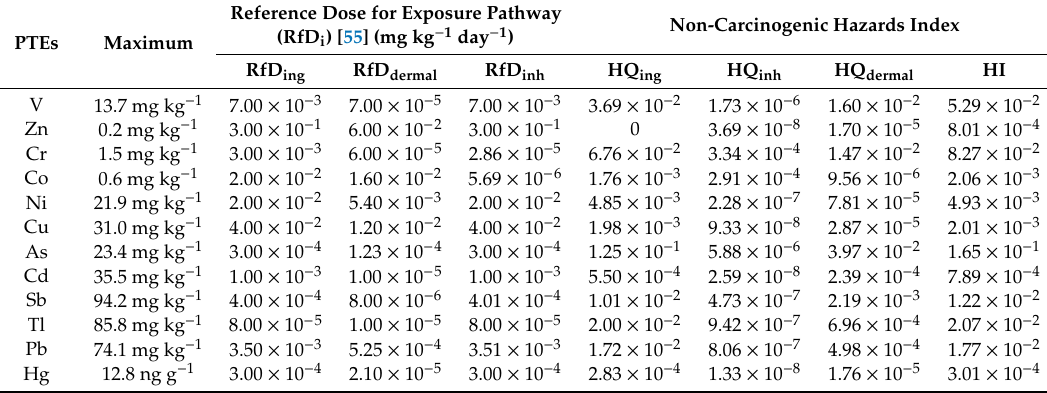
Table 3. Human health risk assessment for potentially toxic elements (PTEs) in the surface soils of the Bosten Lake basin.